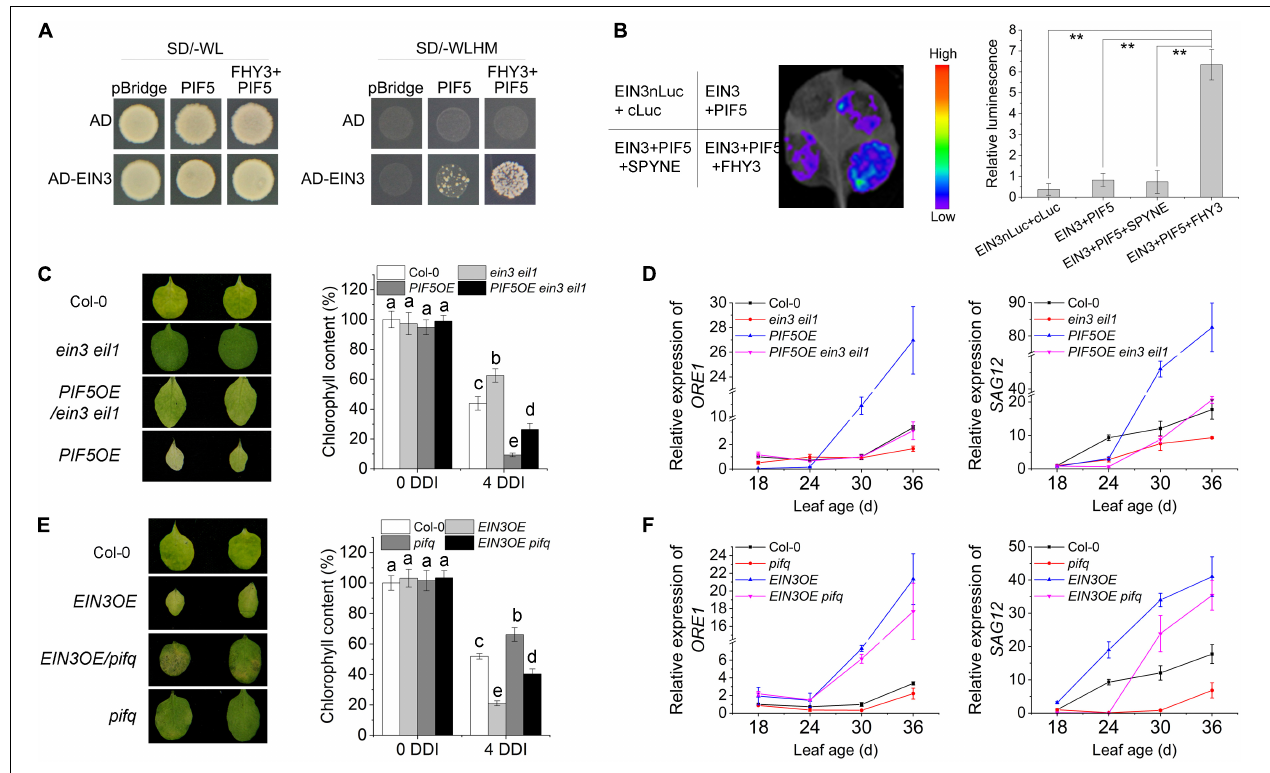
FIGURE 6 | FHY3 and FAR1 mediate the formation of a tri-protein complex to regulate leaf senescence. (A) Yeast three-hybrid assay demonstrates that FHY3 bridges a tri-protein complex containing EIN3, FHY3, and PIF5. (B) Luciferase complementation imaging (LCI) assay and relative luminescence intensity quantification show that FHY3 enhances the interaction between EIN3 and PIF5 in vivo . Error bars represent SD ( n = 3). Letters indicate significant differences by two-sided LSD test ( p < 0.05). (C) The senescence phenotypes and the chlorophyll content of detached leaves of 4-week-old ein3 eil1 , PIF5OE/ein3 eil1, and PIF5OE plants incubated under darkness for 4 days. Letters indicate significant differences by two-sided LSD test ( p < 0.05). (D) Quantitative RT-PCR analysis of ORE1 and SAG12 expression in the fourth leaves of ein3 eil1 , PIF5OE/ein3 eil1 and PIF5OE at the indicated leaf age. Error bars represent SD ( n = 3). (E) The senescence phenotypes and the chlorophyll content of detached leaves of 4-week-old EIN3OE , EIN3OE/pifq and pifq plants incubated under darkness for 4 days. Letters indicate significant differences by two-sided LSD test ( p < 0.05). (F) Quantitative RT-PCR analysis of ORE1 and SAG12 expression in the fourth leaves of EIN3OE , EIN3OE/pifq and pifq at the indicated leaf age. Error bars represent SD ( n =